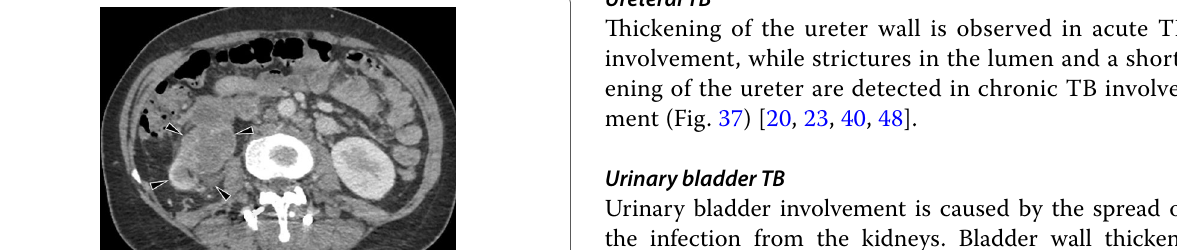
(auto-nephrectomy), calcifications with lobar distribu- tion are pathognomonic [20].